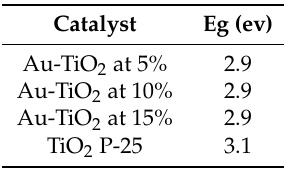
Table 2. Values of the band gap